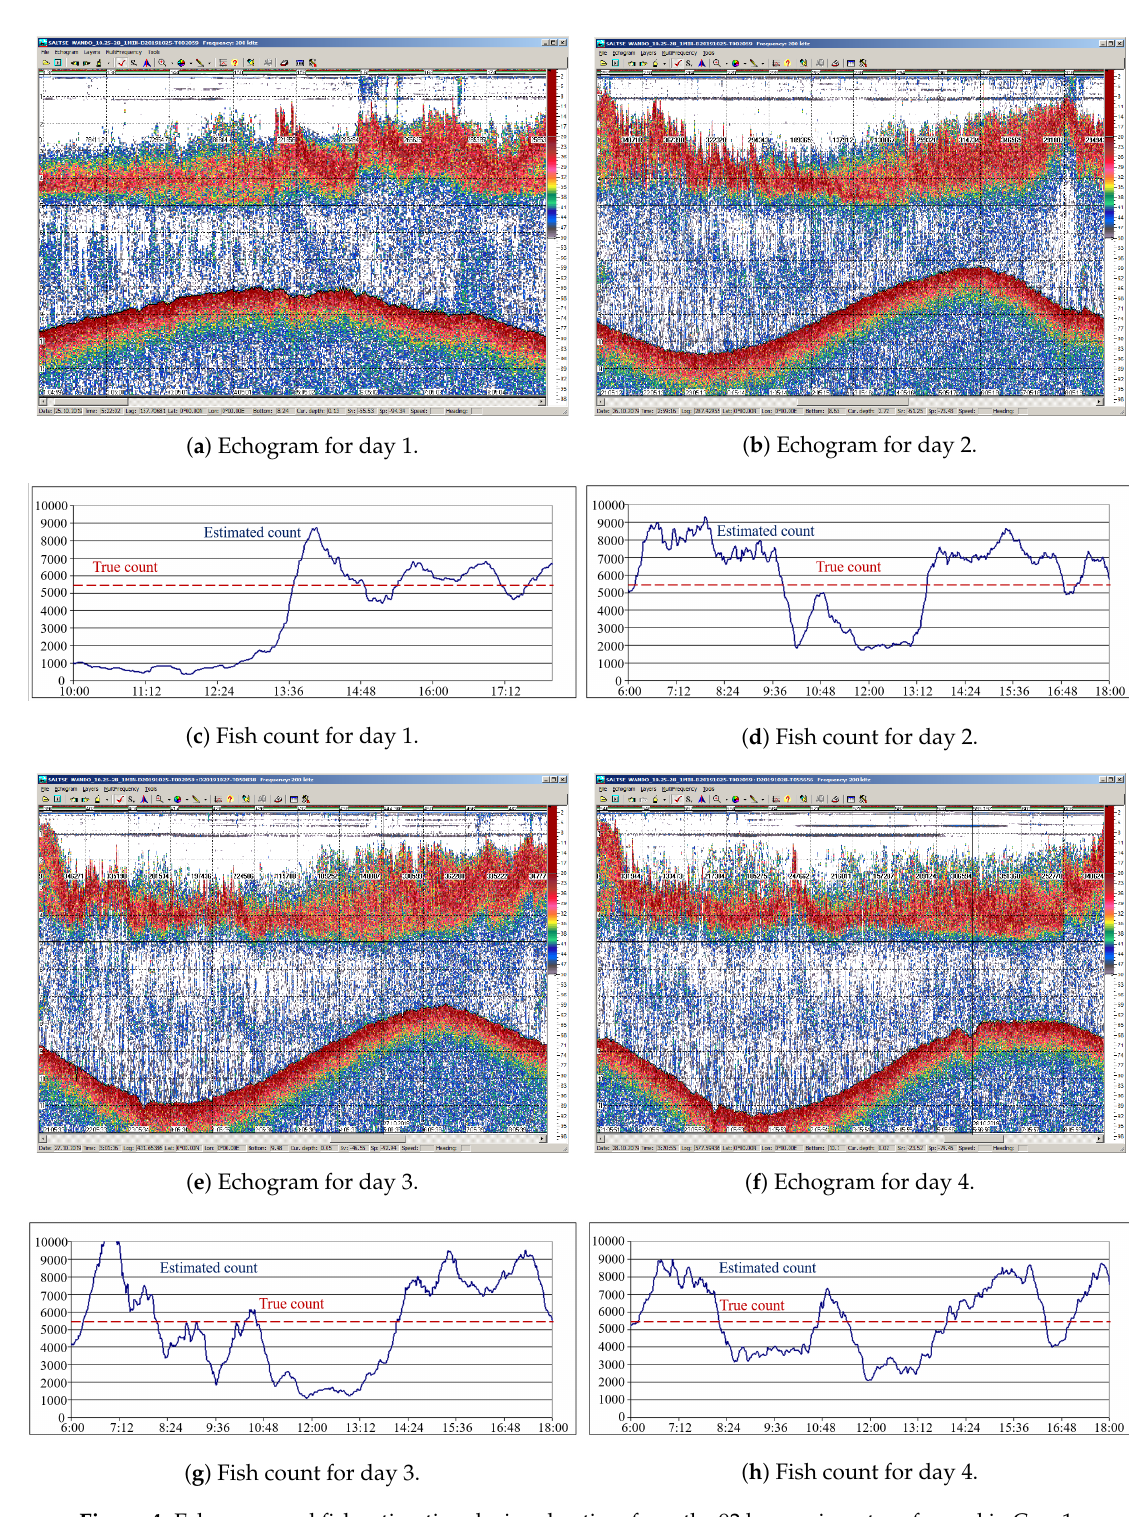
Figure 4. Echogram and fish estimation during day time from the 92 h experiment performed in